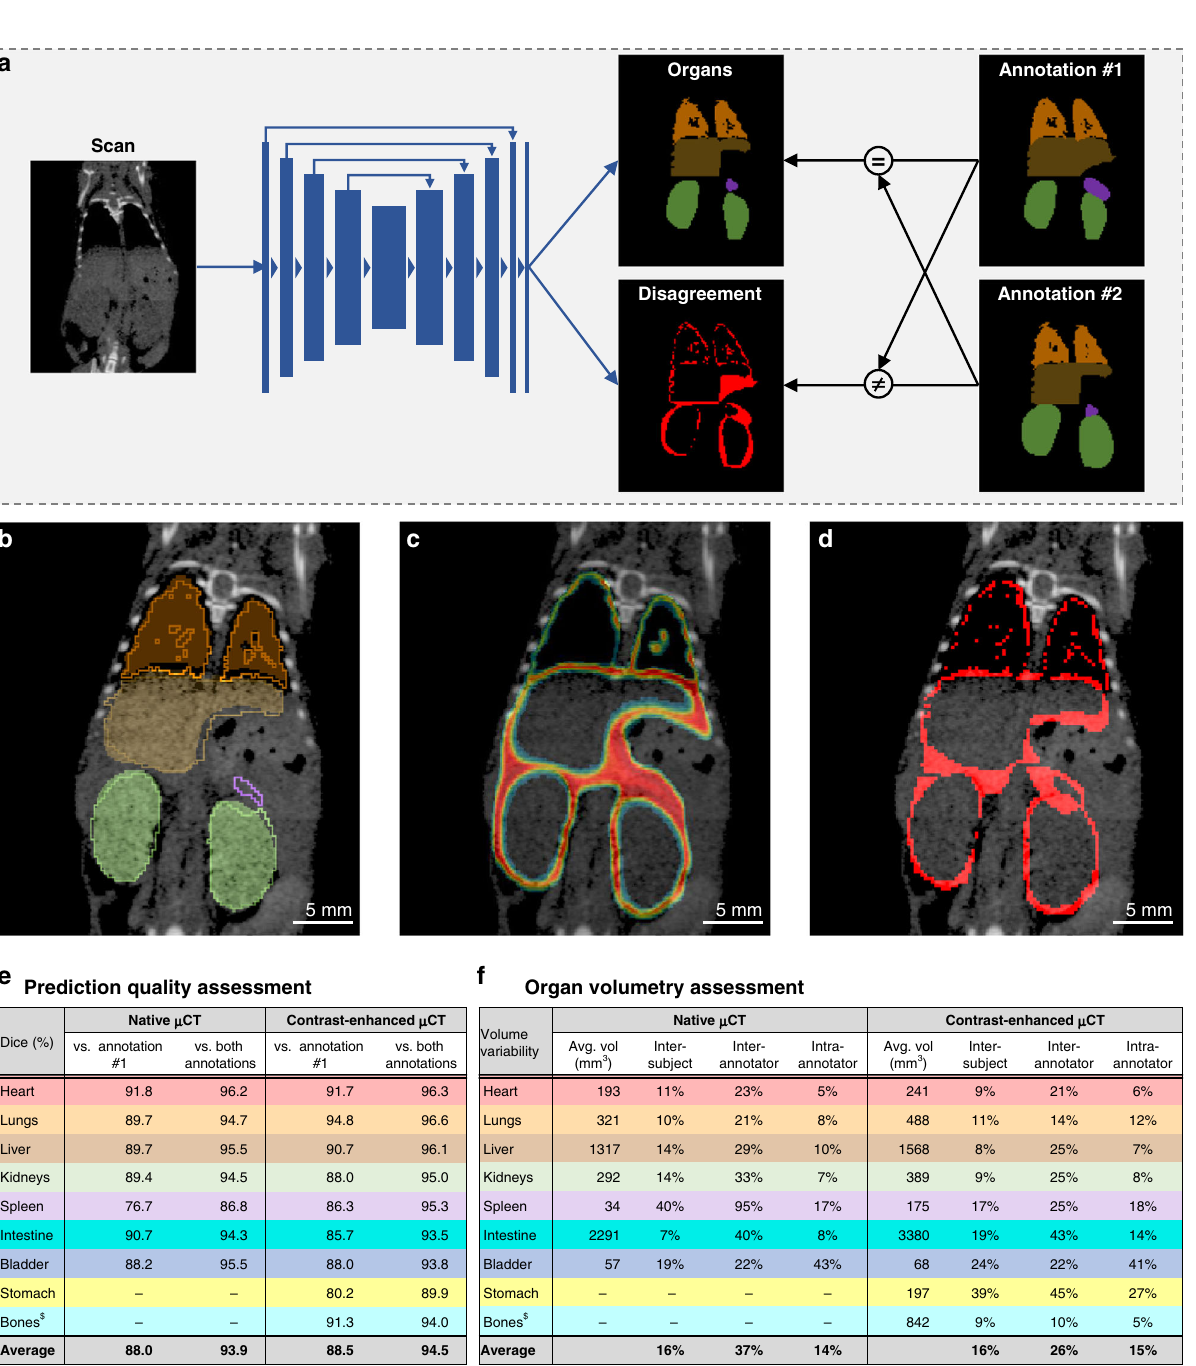
Fig. 5 AIMOS learns to predict areas of likely human disagreement. a Work fl ow for training procedure. Making use of both available human expert annotations, AIMOS is trained to predict not only the location of all organs but also areas of human disagreement. b , c Example of an AIMOS prediction on test data b for organ segmentations (overlaid by a thin line for human labels) and c for likely human disagreement. d Actual human disagreement (difference of both human expert annotations). e Performance of AIMOS prediction of organ segmentations (Dice score) as compared to that of the reference from annotator #1 (left column) and as compared to that of references from both annotators (right column). f Organ volumetry for both datasets. Left column shows average volume per organ across mice; other columns show variability (standard deviation relative to average volume) across mice (intersubject), across annotations from two annotators for the same scan (interannotator), and across annotations for the same mouse from the same annotator (intraannotator). $Semiautomatic thresholding aided human segmentations of bones and may thus underestimate intraannotator and interannotator